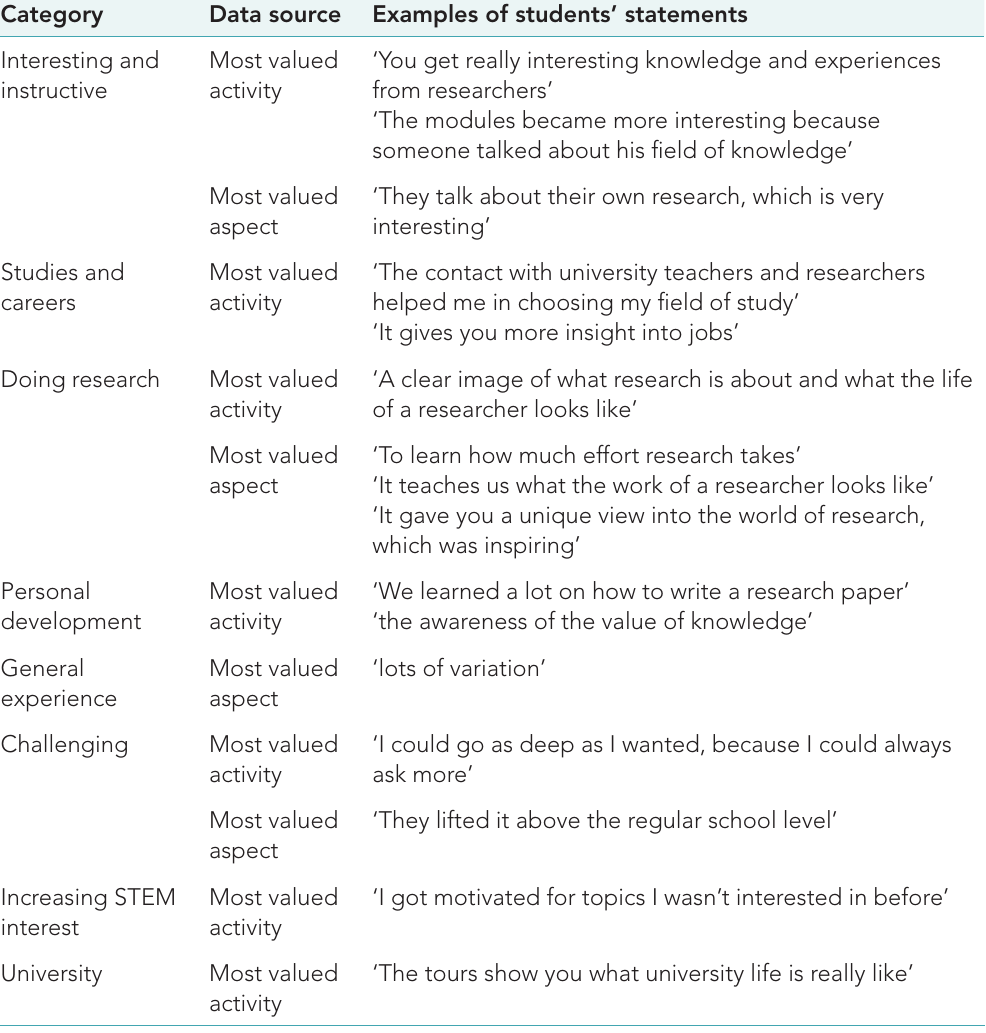
Table 7b: Examples of students’ statements relating to their interaction with researchers, from the questionnaire at the end of the UTA for graduation year 2017 Category Examples of students’